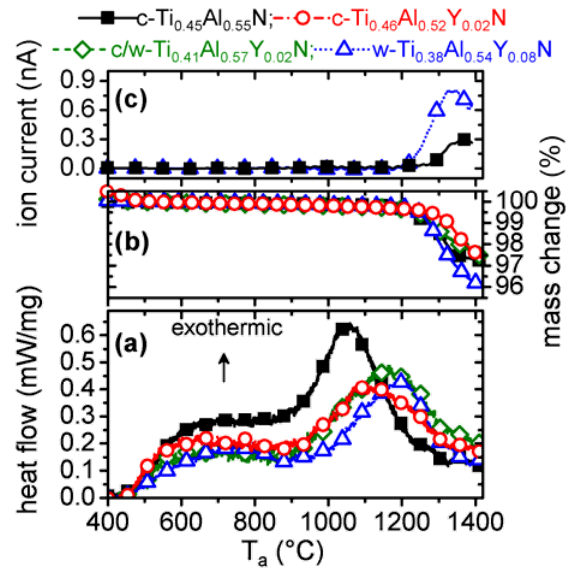
1. Simultaneous thermal analysis of c-Ti c-Ti Al Y N (2 mol % YN), binary c/w-Ti 0.46 0.52 0.02 phase w-Ti Al Y N (8 mol % YN) in He atmosphere up to 1400 °C. (a) DSC, 0.38 0.54 0.08